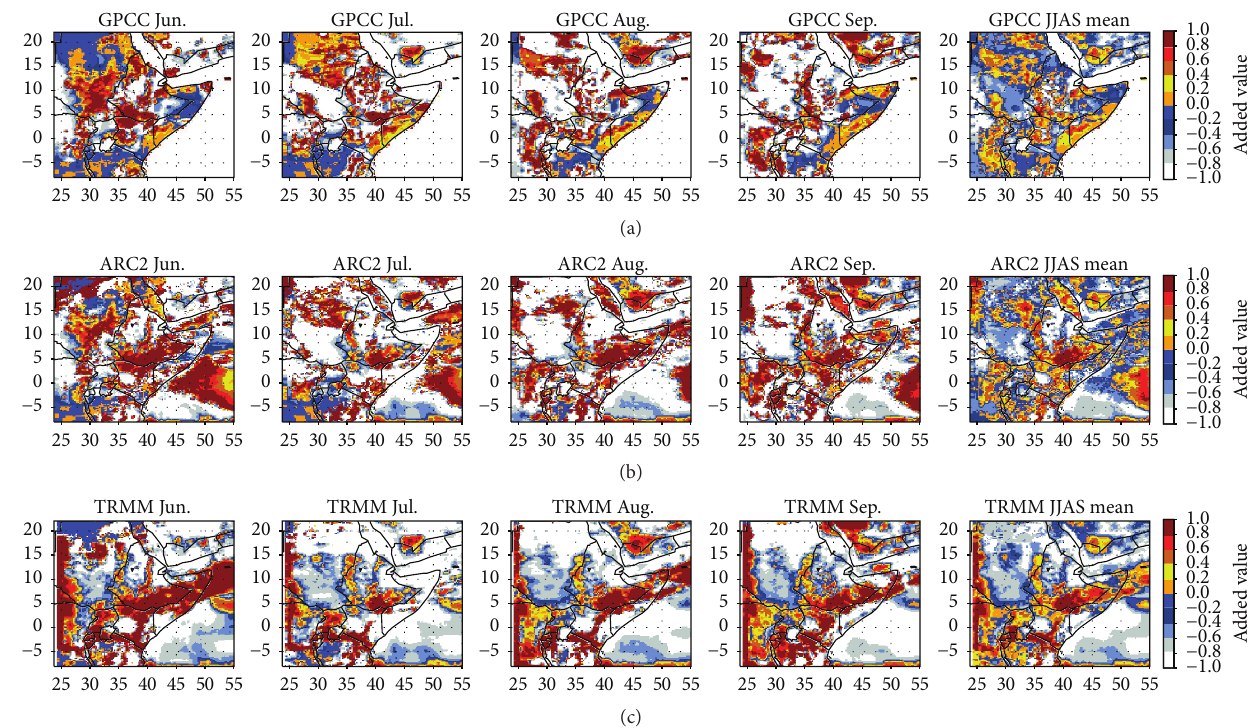
Figure 6: Maps of real added value of COSMO-CLM over MPI-ESM: from top to down with respect to GPCC, ARC2, and TRMM. Each of the columns represents, respectively, June, July, August, September, and JJAS average.